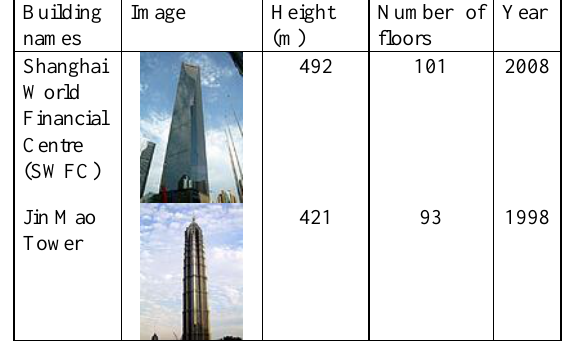
Table 1. Major parameters of the two landmark buildings.